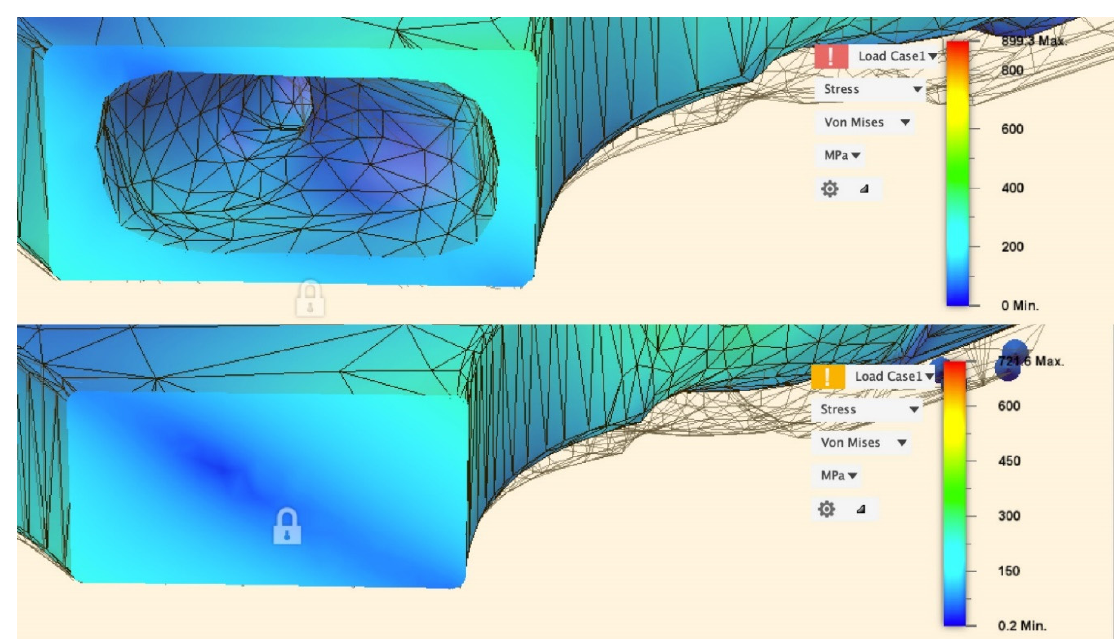
Figure 7. Maximum neck and stem stresses in the selectively hollowed (left) and solid (right) im- plants. The selectively hollowed implant had marginally lower neck stresses, but higher internal stem stresses compared to its solid equivalent. The image is cropped 10 mm from the distal fixed face.